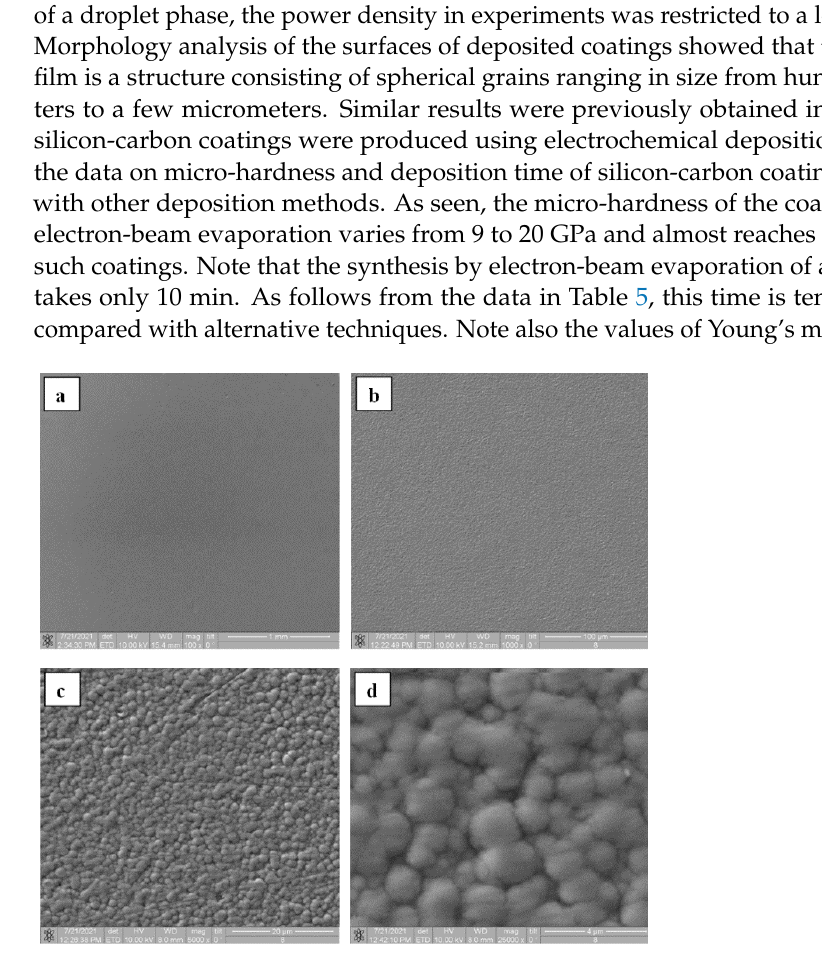
Figure 34. Micrographs of the obtained coatings at various magnifications: ( а ) 500×, ( b ) 1000×, ( c ) 5000×, ( d ) 25,000×. ( c ) 5000 × , ( d ) 25,000 ×